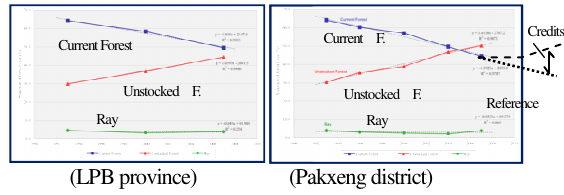
Figure 5 Historical trends of forest cover